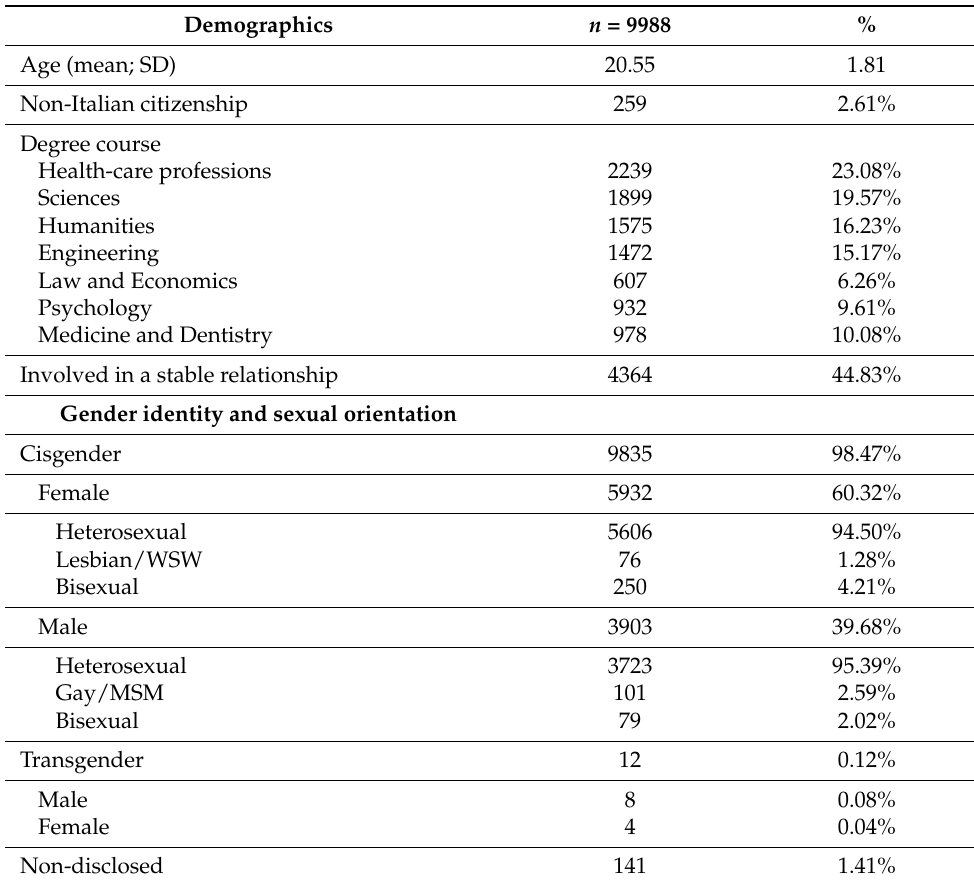
Table 1. Socio-demographic characteristics of the study population.